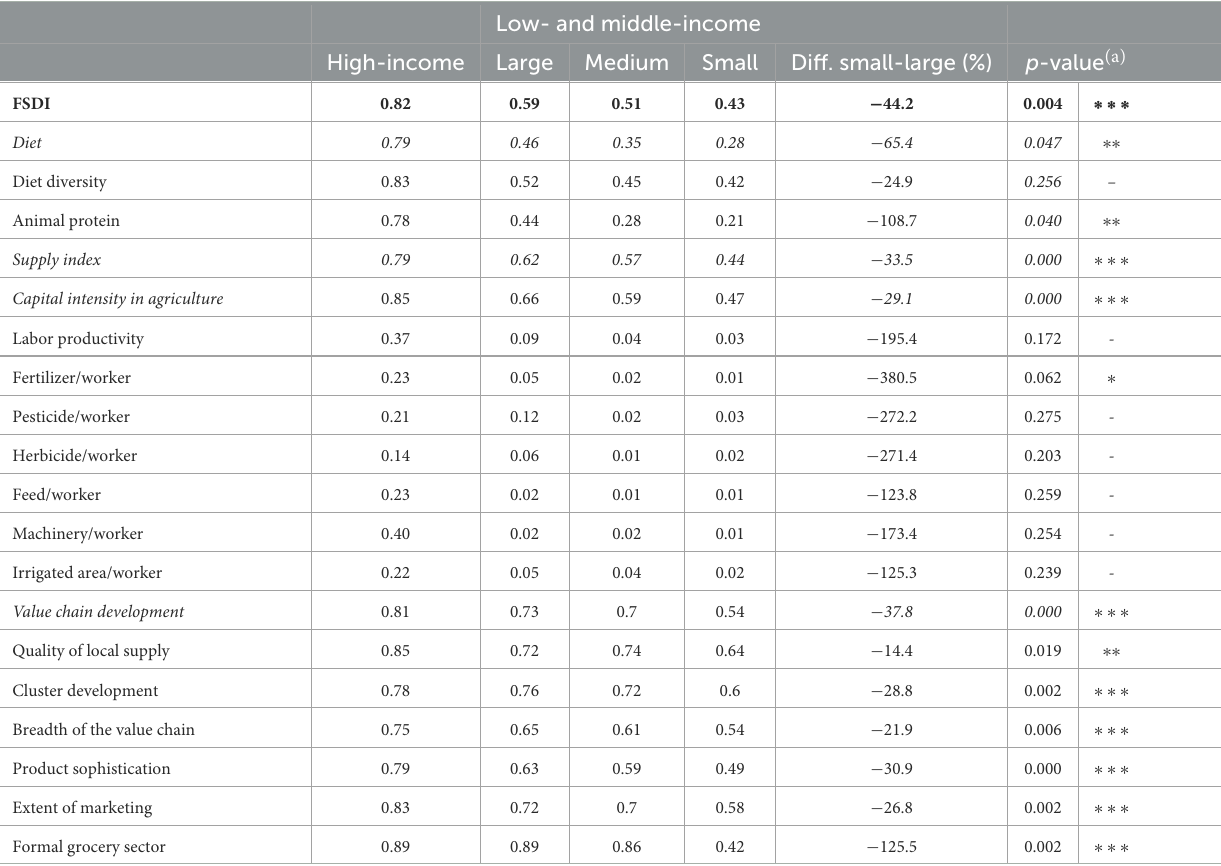
TABLE 2 The Food System Development Index and its components for HICs and LMICs grouped by the size of their agricultural research systems, average values for 2011–2016. Low- and middle-income High-income Large Medium